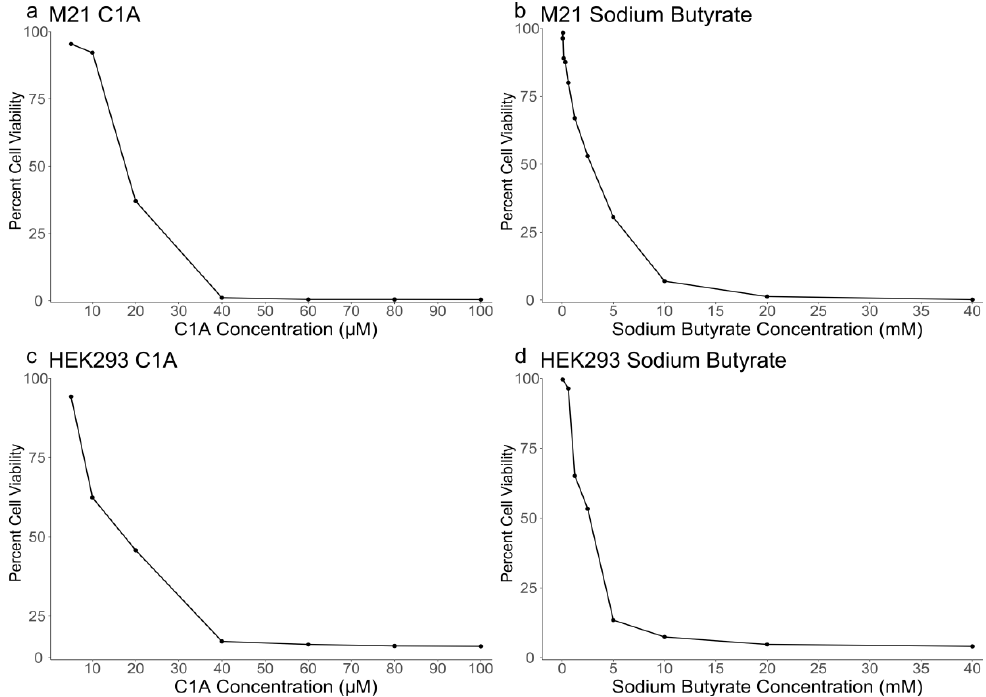
Table 1. Median lethal concentration of C1A and sodium butyrate after 24 h of treatment.